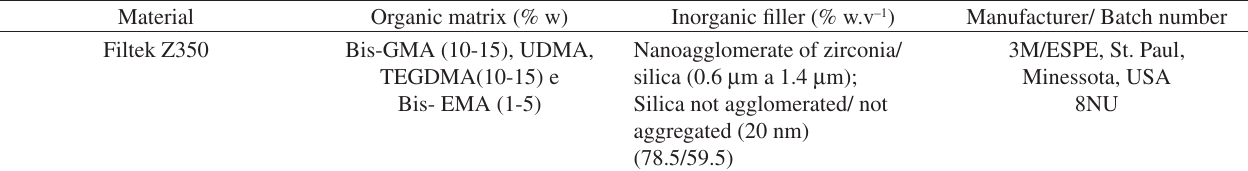
Table 1. Resin composite and composition according to the manufacturer’s information. Material